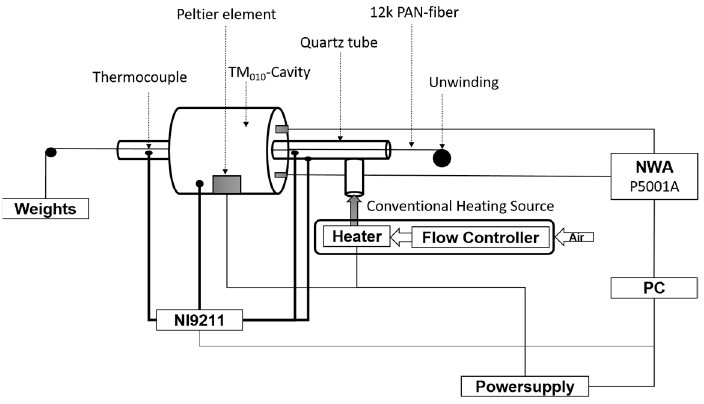
Figure 3. Schematic drawing of in-situ measurement setup of the temperature-dependent dielectric properties.